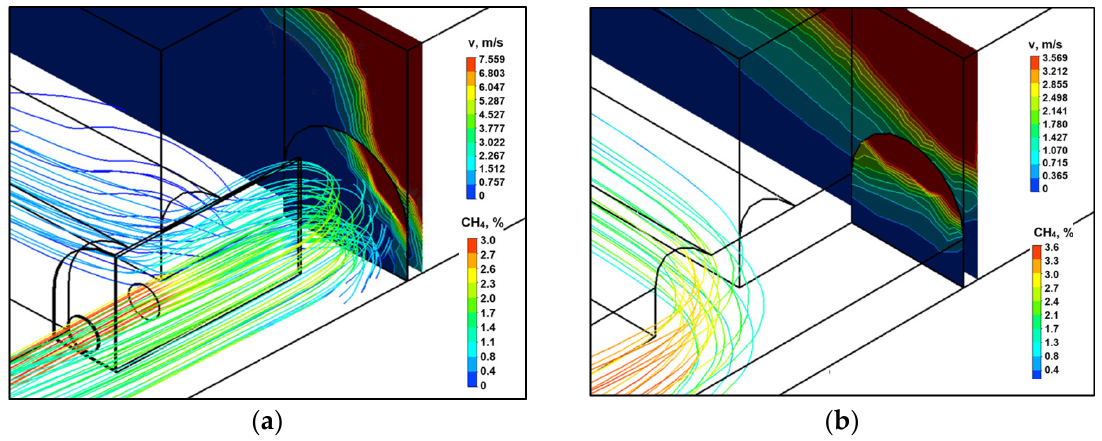
Figure 15. The manner in which methane is released from the goaf with caving into the tailgate with built-in AVE ( a ) and without such equipment ( b ).